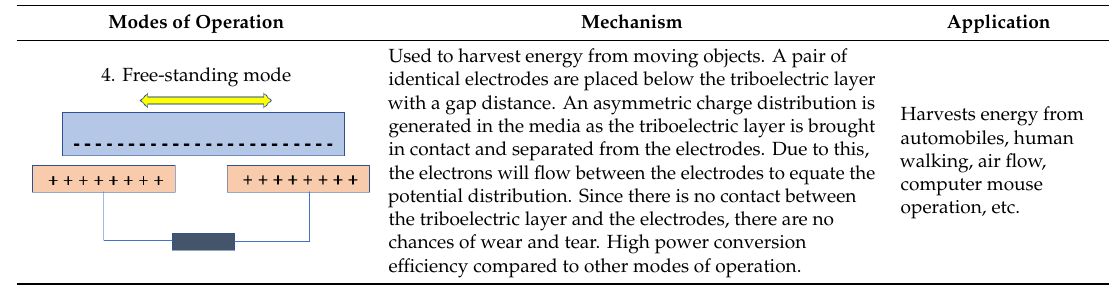
Table 4. Triboelectric series for some commonly available materials [95].